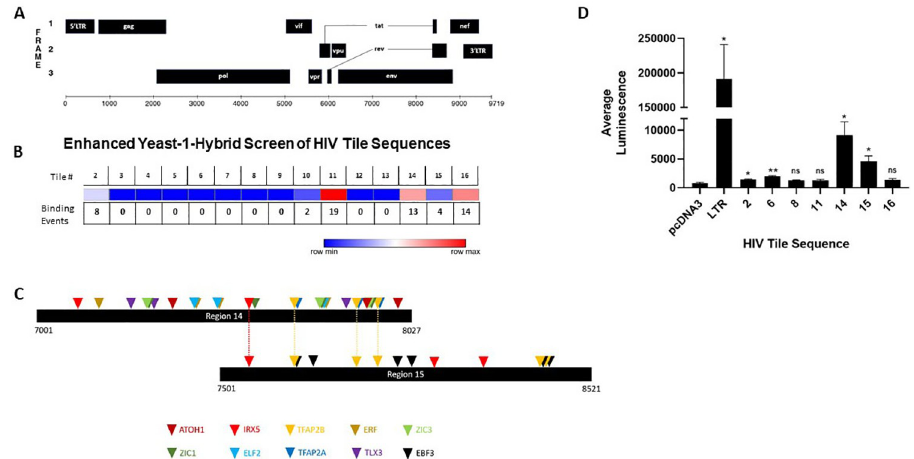
Fig 5. Identification of intragenic transcriptional elements. (A) Schematic of HIV-1 genome. (B) Heat map for transcription factor binding within the HIV-1 provirus. HIV-1 tile sequences (1–16) were used in yeast-1-hybrid screen (See S4 Table). Dark blue represents regions lacking transcription factor binding whereas red indicates regions of transcription factor binding. Binding events represent the number of transcription factors that bound the specific HIV-1 genomic sequence. (C) Location of predicted binding sites for transcription factors identified by yeast-1 hybrid assay that bind baits 14 and 15. Motifs were identified using FIMO with a threshold set at p < 0.001 ([38] and S6 Table). (D) Intragenic sequences enhance transcription. HIV-1 tile sequences were cloned upstream of a luciferase gene in pcDNA3.1 Luciferase and transfected in HEK-293T cells. Luciferase was measured and reported as fold-change in signal over cells transfected with the negative control pcDNA3.1-Luc plasmid. HIV-LTR-Luciferase was used as a positive control. These data include three independent transfections performed in triplicate. Error bars represent standard error of the mean for all values. Two-tailed unpaired T-tests were used to calculate statistical significance between raw luminescence values for HIV-1 tile sequences and negative control pcDNA3.1-Luc plasmid. � denotes p < 0.05; �� denotes p < 0.01, and ��� denotes p < 0.001. TATA box motifs (7483–7488 bp and 7662–7669 bp) within the env sequence, adjacent to the start sites identified by 5’ RACE (Fig 4B and 4C). Alignment of 5’ RACE PCR sequences to the